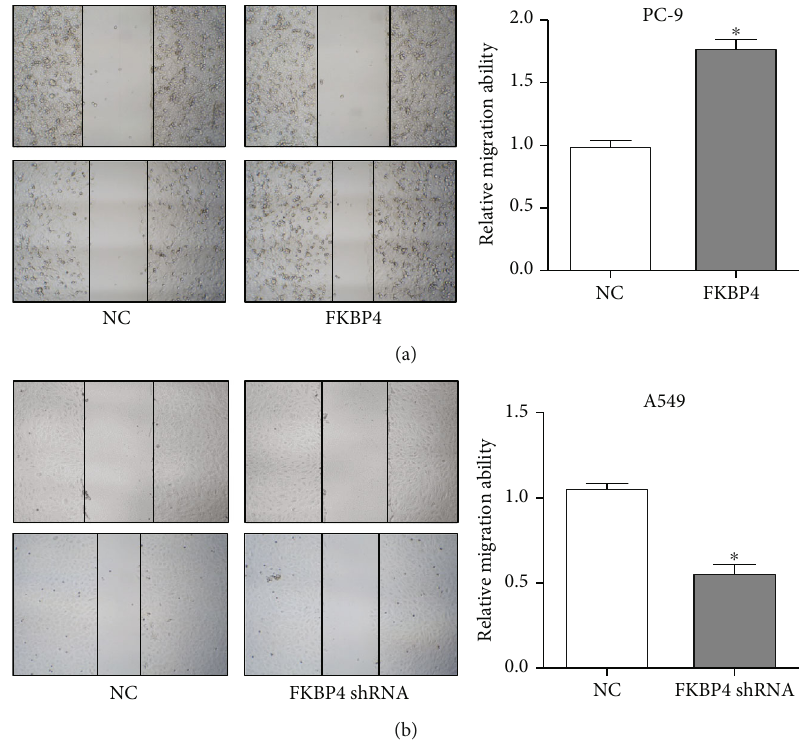
Figure 7: FKBP4 promotes NSCLC cell migration: cell migration after overexpression of FKBP4 (a) in PC-9 cells and silencing of FKBP4 (b) in A549 cells; N = 3 , ∗ P < 0 : 05 .